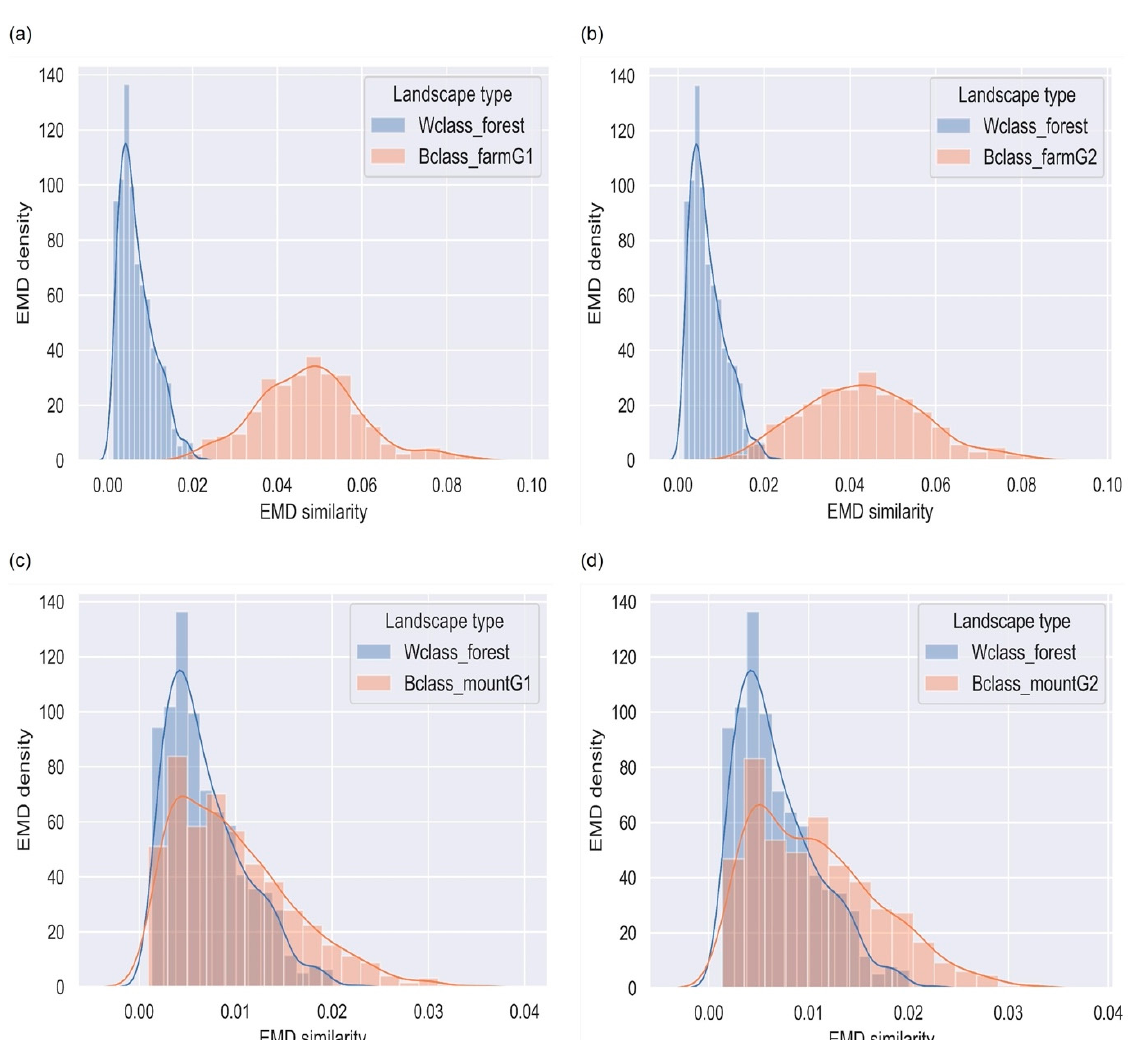
Figure 13. Forest landscapes from AID dataset. Row ( a ) denotes a sample image and its feature maps. Row ( b ) is sample of forest landscape from the different location. Notice that Filters 11, 15, and 53 depict features with varying grain sizes, yet they originate from an identical forest landscape.